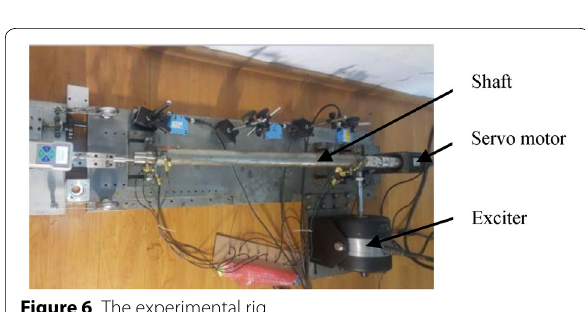
Figure 6 The experimental rig